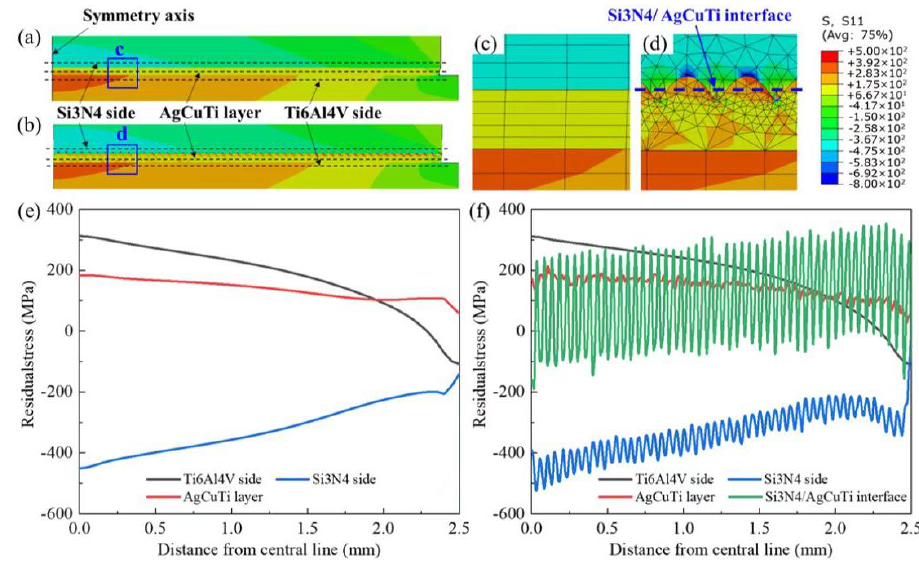
Figure 12. ( a ) Pristine surface, ( b ) residual stress τ zx results of the dense surface joint and the schematic of the extraction position, ( c , d ) partially enlarged views, ( e ) pristine surface, and ( f ) residual stress distribution curve of the dense surface